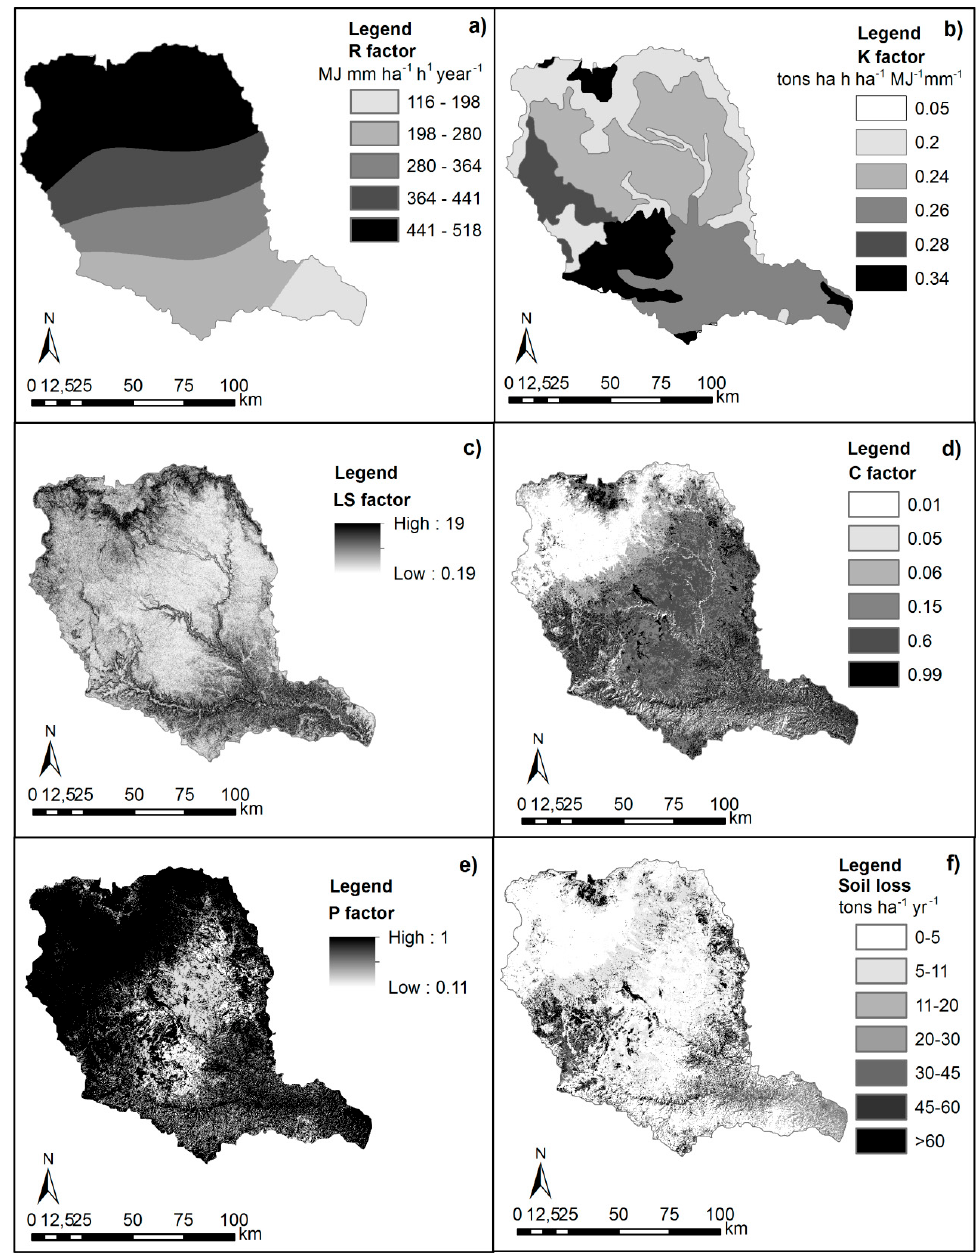
Figure 4. R-factor map ( a ), K-factor map ( b ), LS-factor map ( c ), C-factor map ( d ), P-factor map ( e ) and soil loss map ( f ) of the Welmel catchment.